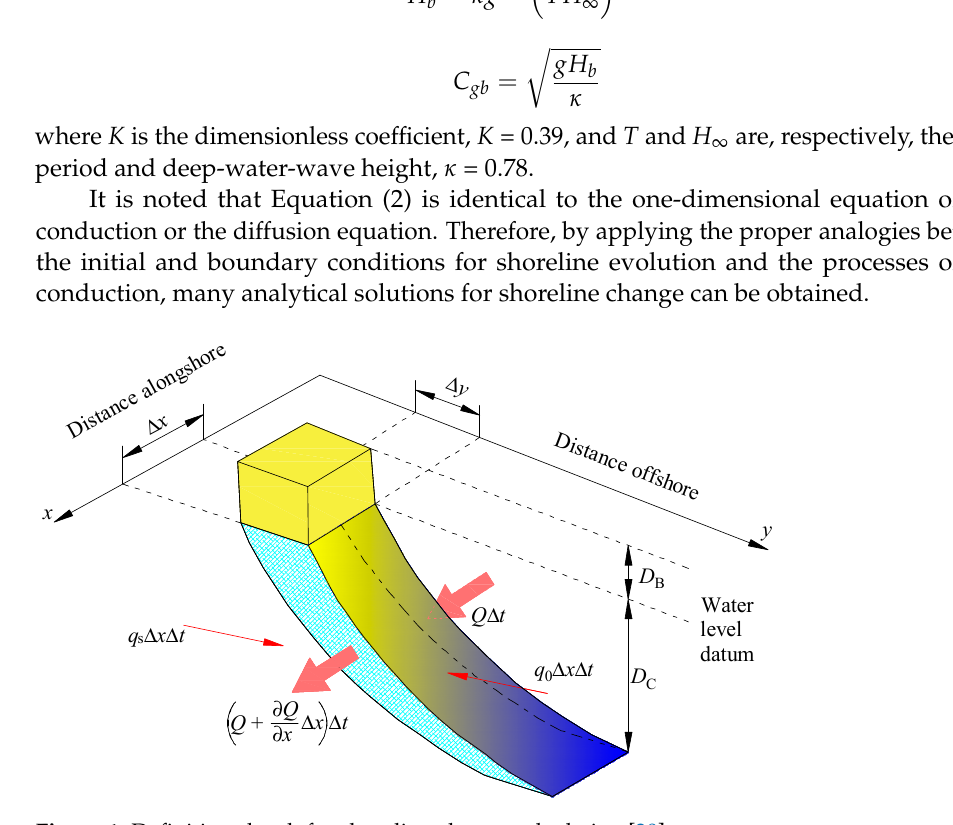
Figure 1. Definition sketch for shoreline-change calculation [30].